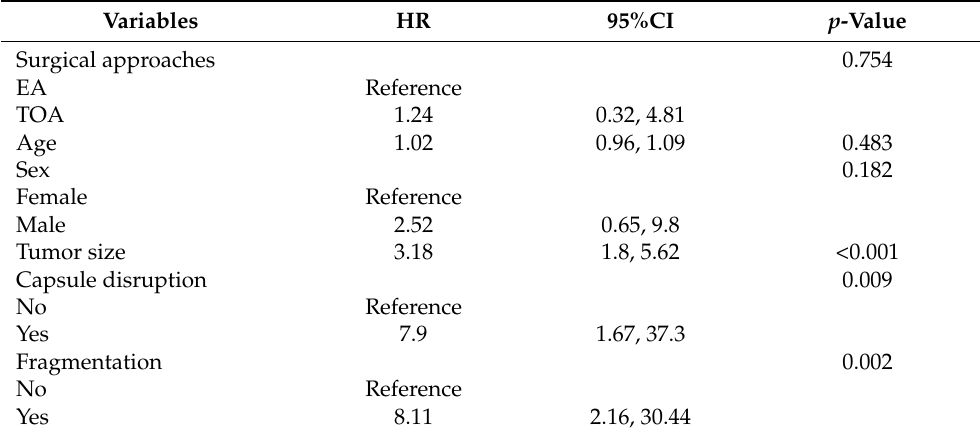
Table 2. Univariate Cox proportional hazards models evaluating the association between the variables and recurrence rate before PSM.